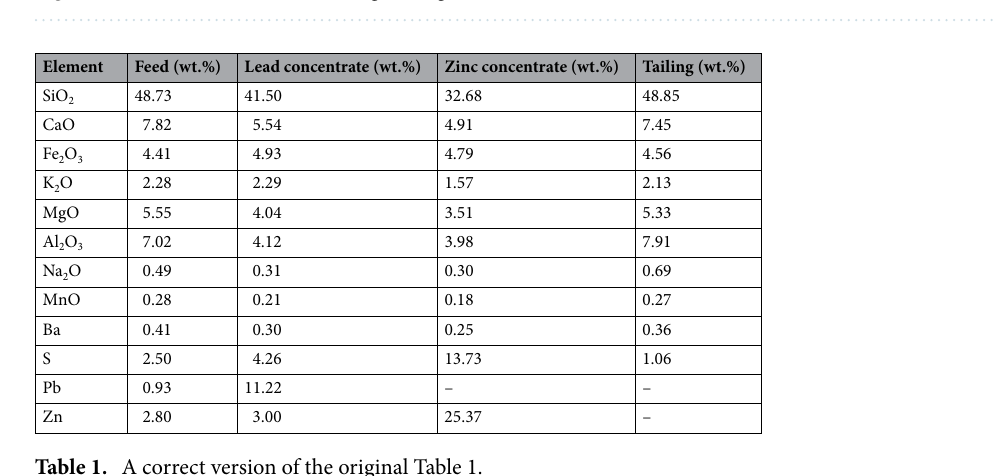
Figure 1. A correct version of the original Figure 1.